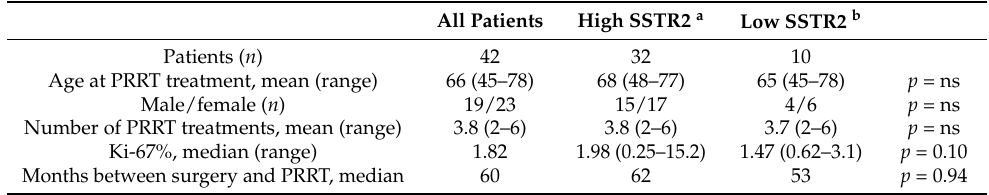
Table 1. Clinical characteristics of PRRT treated patients.